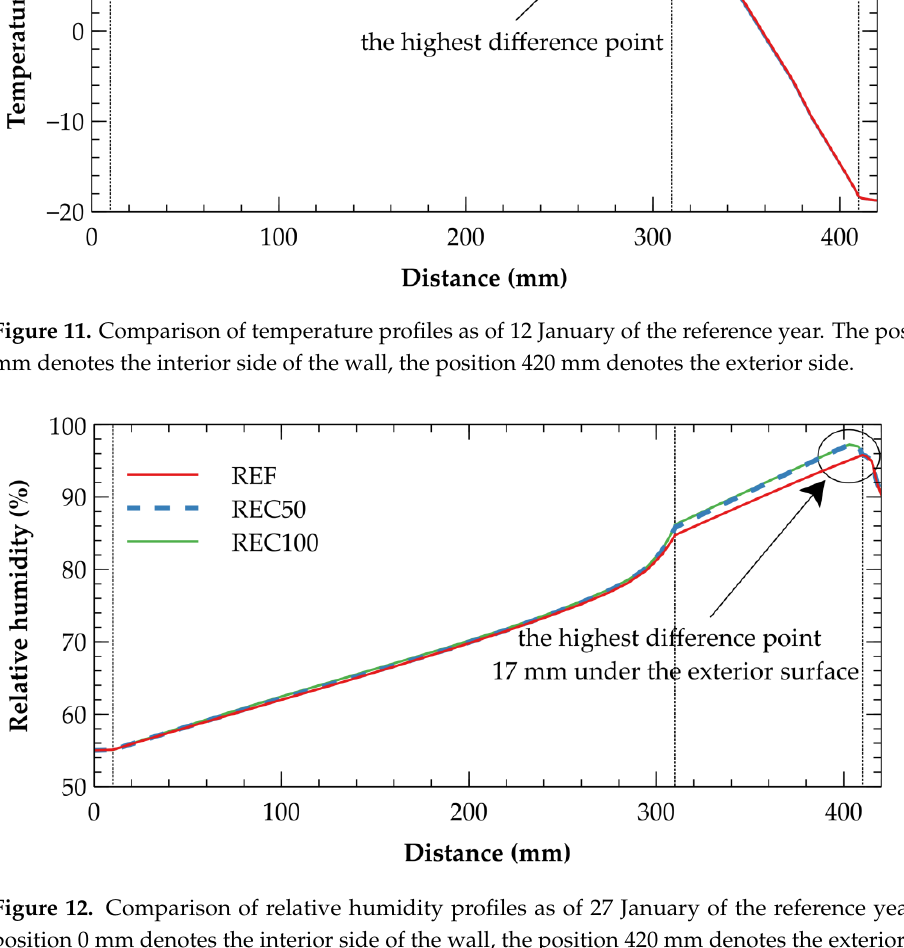
Table 5. Results of assessment of environmental impacts—selected midpoint indicators.